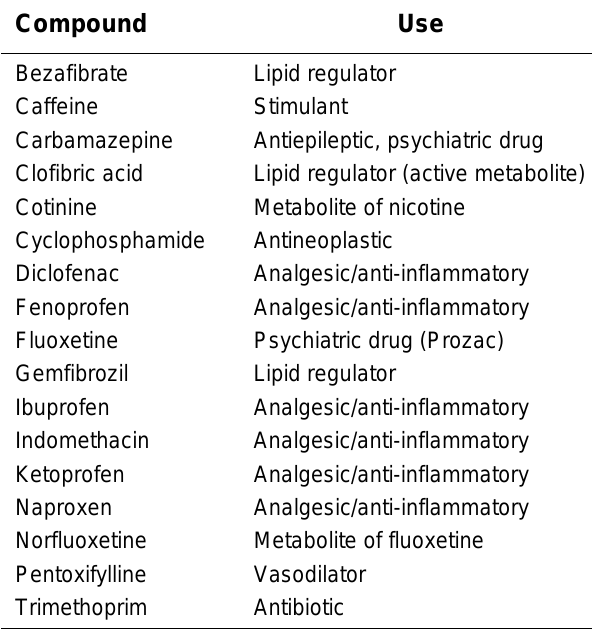
Select Pharmaceutical Compounds Found in Wastewater